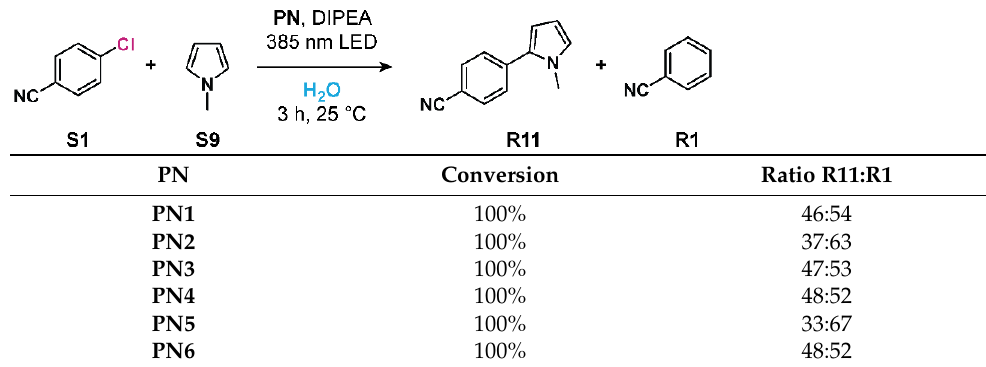
Table 3. C-C cross-coupling of 4-chlorobenzonitrile S1 and N -methylpyrrole S9 . Full conversion of 4-chlorobenzonitrile was observed, forming both the C-C cross-coupled R11 and dehalogenated R1 product. The selectivity to both products is shown as ratio of R11 and R1 . The reactions were prepared according to the general protocol discussed in the experimental section, with the addition of 5 equivalents of N -methylpyrrole S9 1 .